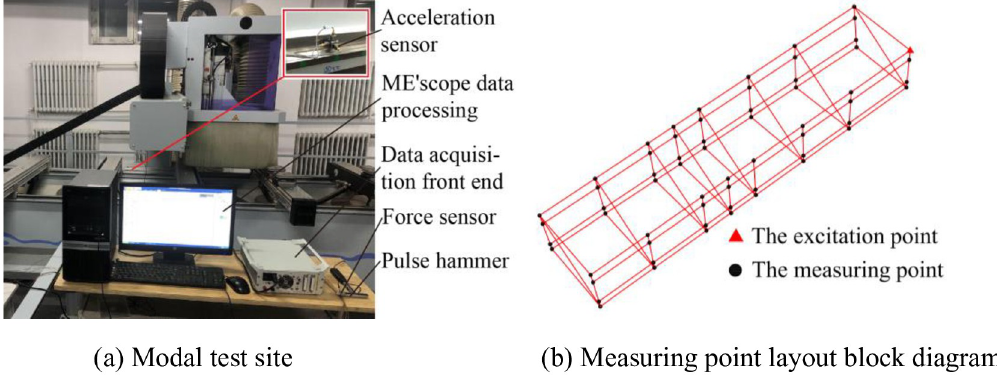
Fig 6. Modal test site and test point layout. (a) Modal test site, (b) Measuring point layout block